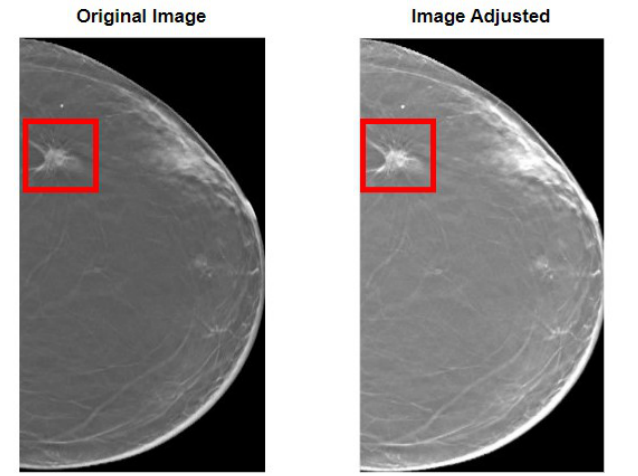
Figure 3. Results of the image adjustment procedure. On the left, the original image is shown with a bounding box encapsulating the lesion. On the right, the same can be seen but for the image after adjusting. It can be perceived how the lesion becomes more